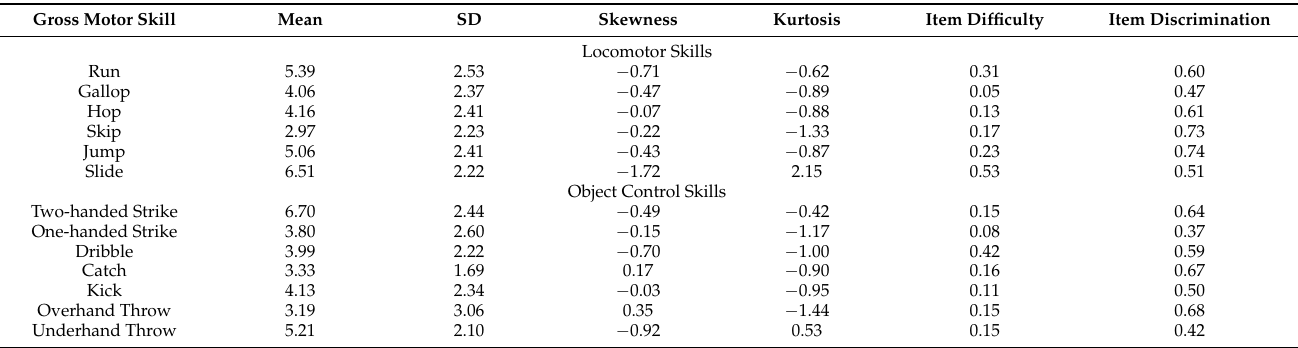
Table 1. Descriptive statistics for individual skills.